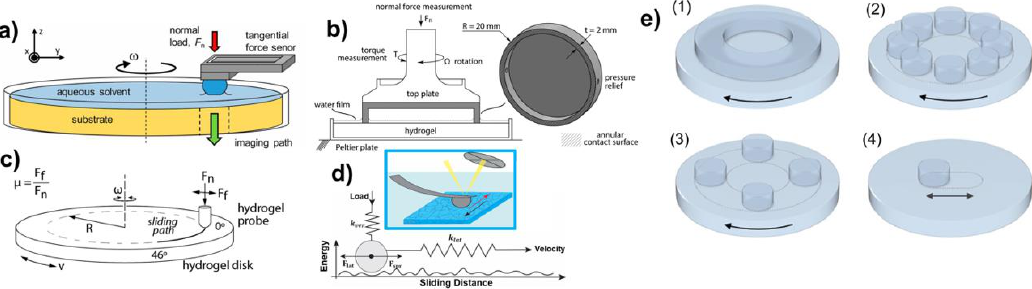
Figure 2. Schematics of typical contact configurations in friction force measurements on hydrogels.